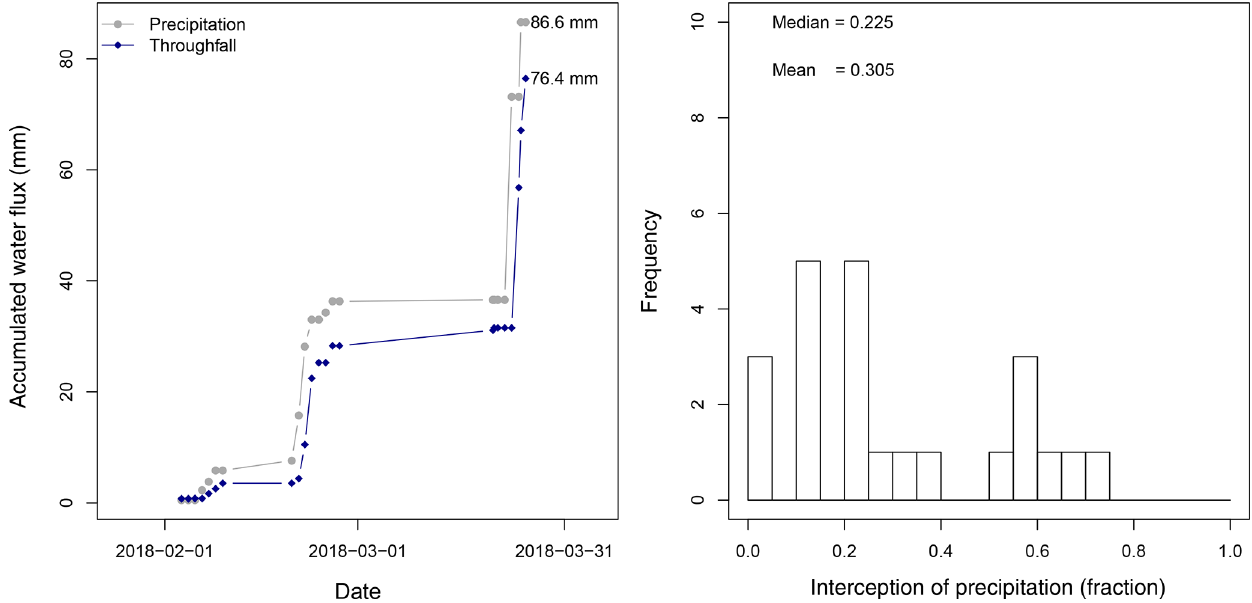
Figure H1. Analysis of the interception of precipitation for the sampling carried out at La Selva Biological